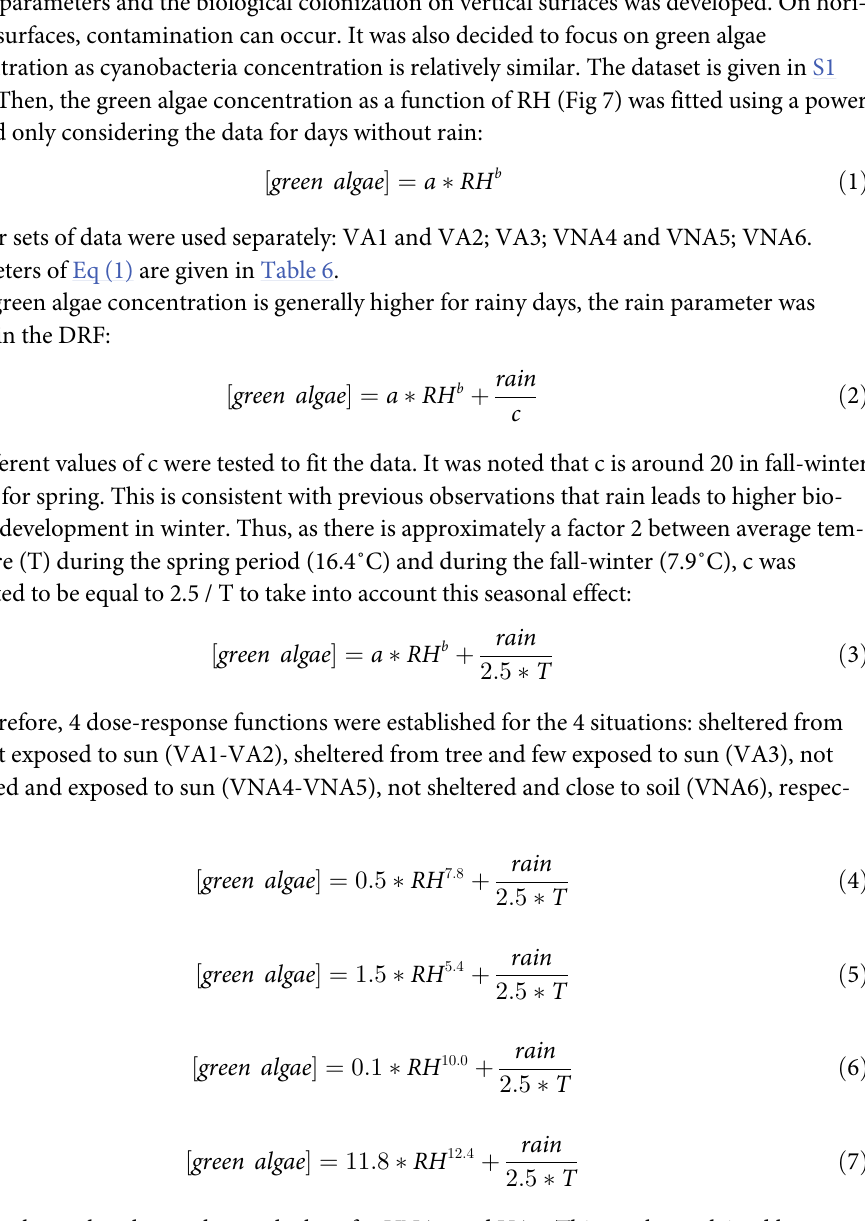
Table 6. Fitting parameters of green algae concentration as a function of relative humidity (RH) for not-rainy days using a power law (Eq (1)): A, a-range for a 95% confidence interval, b, b-range for a 95% confidence interval, R 2 .